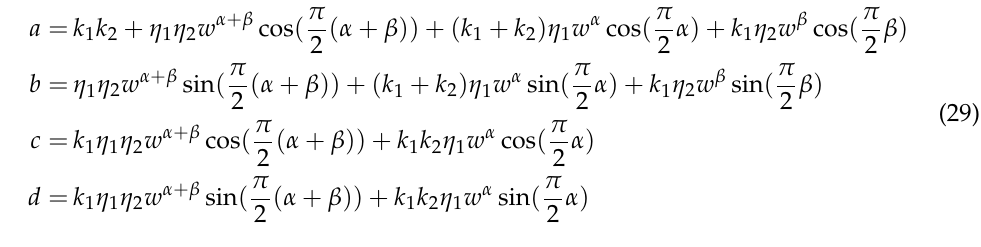
(keep k 1 = 160 × 10 6 N/m, η 1,2 = 0.1 × 10 6 N · s/m, α = 1). The stiffness and damping